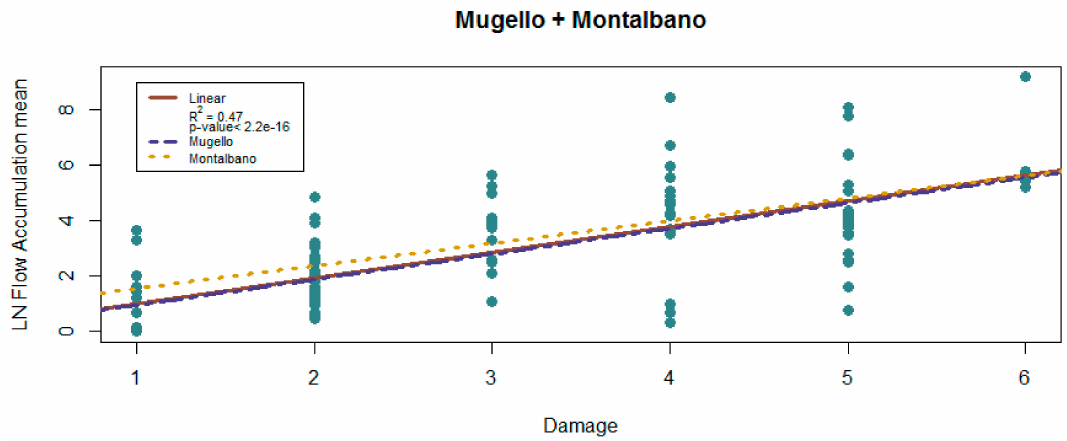
Figure 8. Scatter plot of the damage classes and flow accumulations from both areas. In both study areas we found a statistically significant correlation between the dam- age classes and the flow accumulation values (Mugello R 2 = 0.57, p < 0.001; Montalbano R 2 = 0.14, p < 0.01). In Mugello, the statistical significance of the correlation was higher than in Montalbano because of the higher variability in the Montalbano flow accumula- tion data (Montalbano = 19% Mugello, in sample points terms). If we plot the median flow accumulation against the damage class, the correlation is even higher (R 2 = 0.88, p < 0.005, Figure 9).